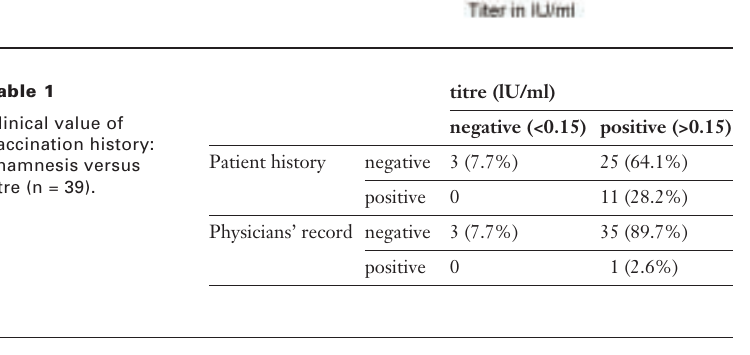
Clinical value of vaccination history: physicians’ record versus patients’ history (n=40)